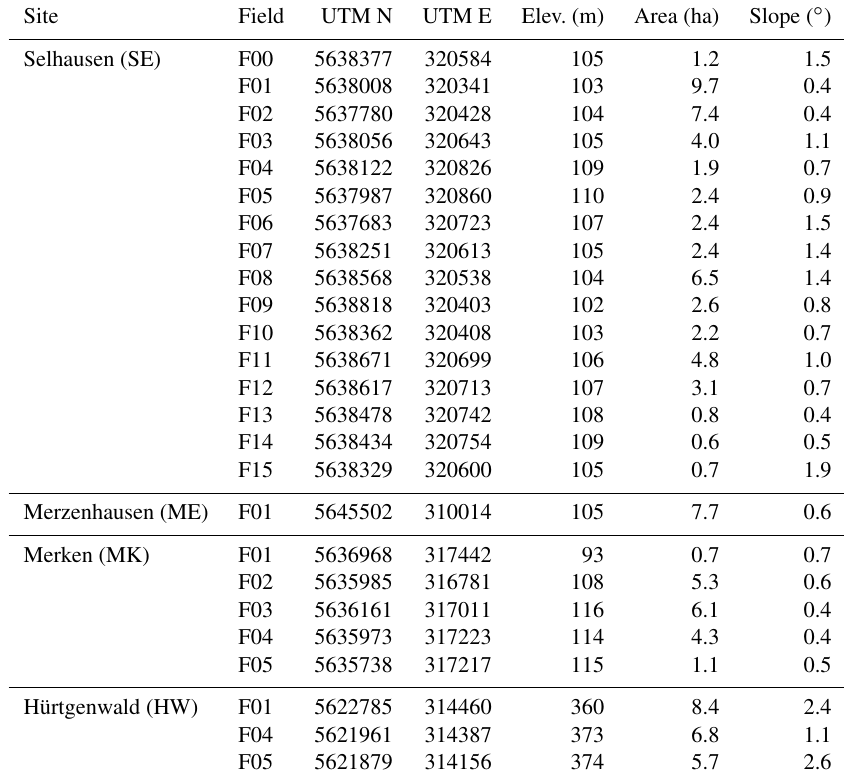
Table 1. Terrain properties of the fields. Coordinates are for centroids; projection is UTM 32N (WGS